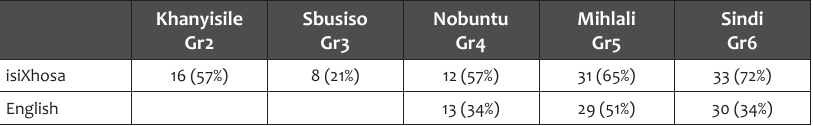
Table 5: ‘Retained meaning’ and ‘Partial meaning loss’